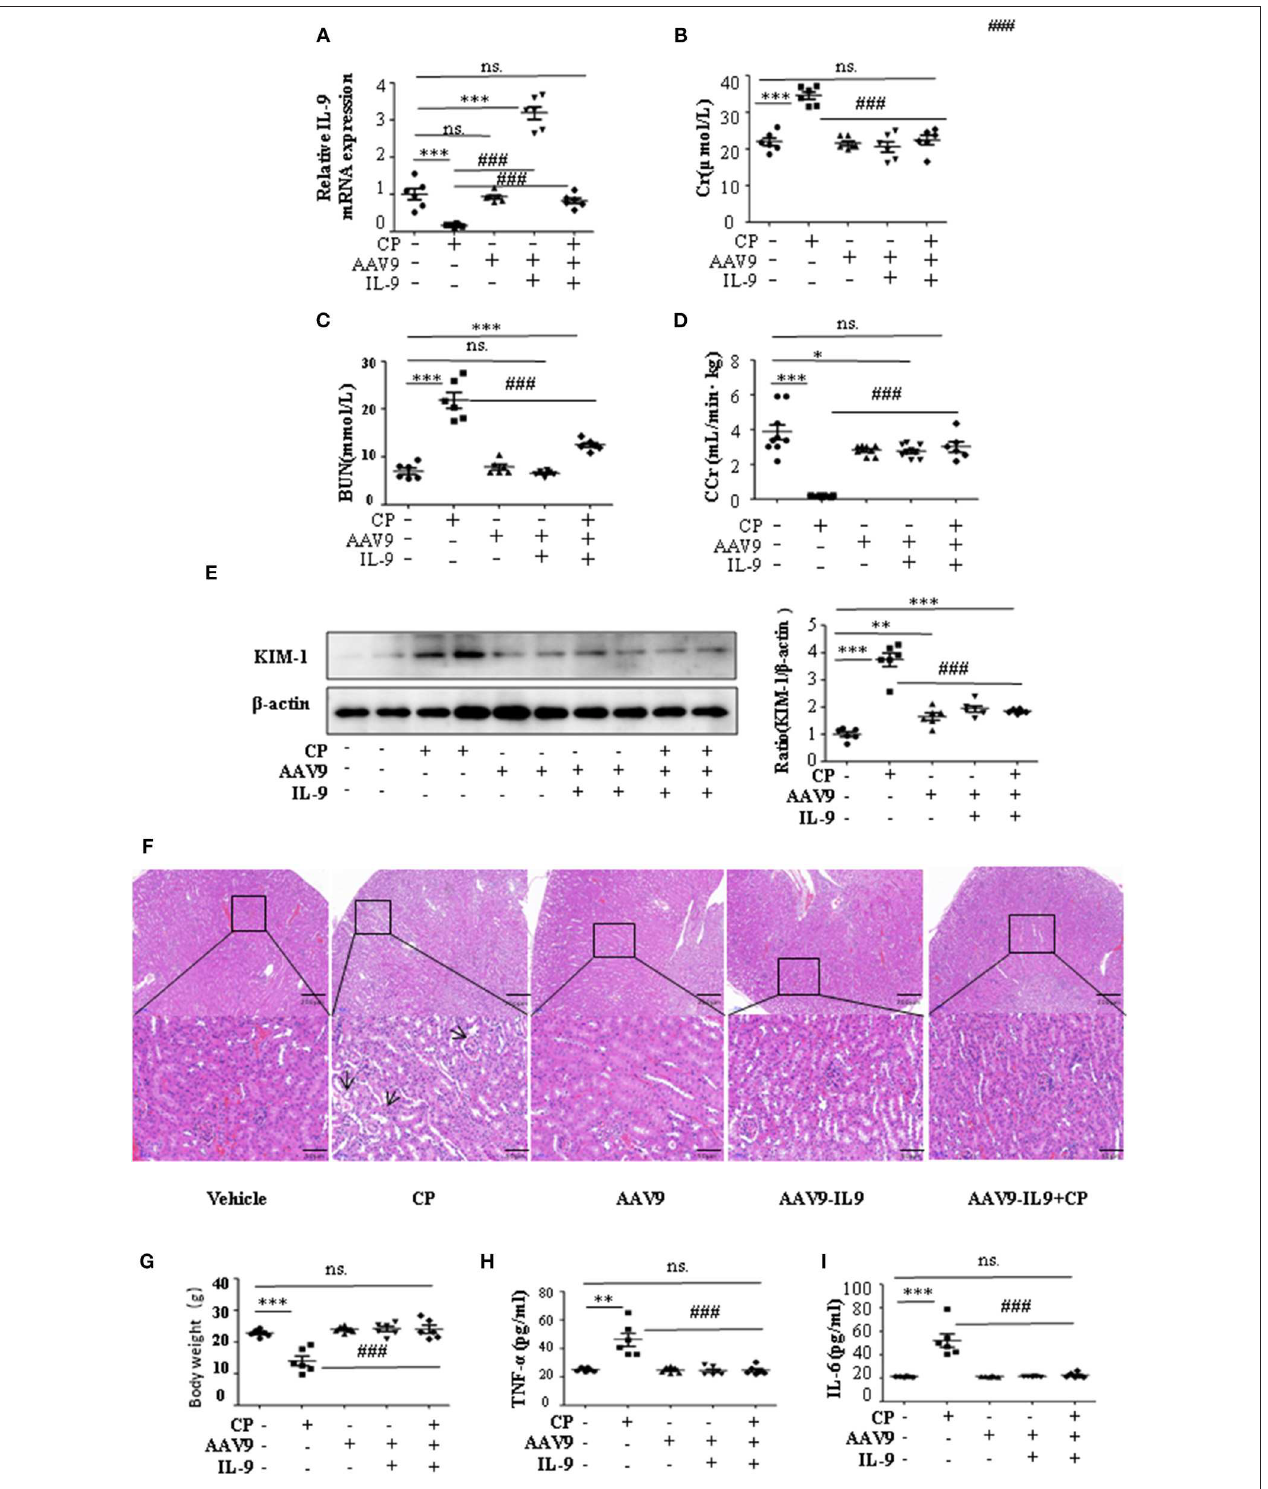
FIGURE 2 | Interleukin-9 (IL-9) alleviated cisplatin (CP)-induced acute kidney injury. Mice were injected with adeno-associated virus 9 (AAV9)-IL9 vectors by tail vein injections to confirm the overexpression of IL-9 in kidneys then induced by CP (20 mg/kg) as the AAV9-IL9 + CP group. Mice were injected with AAV9-IL9 vectors by tail vein injections without CP injection as the AAV9-IL9 group. Mice were injected with AAV9 empty vectors by tail vein injections without CP injection as the AAV9 group. Mice were induced with a single intraperitoneal injection of CP as the CP group. Mice were given a single intraperitoneal injection of saline as the vehicle